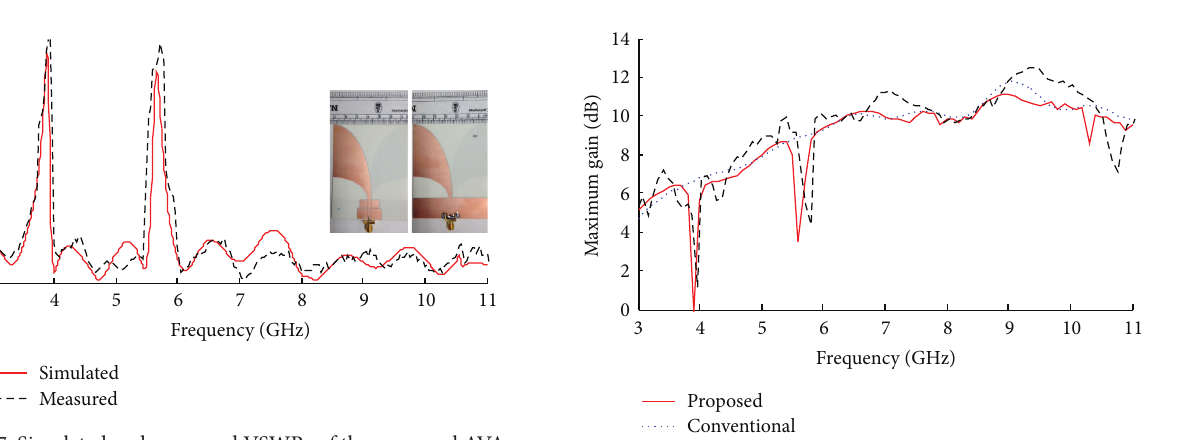
Figure 7: Simulated and measured VSWRs of the proposed AVA.